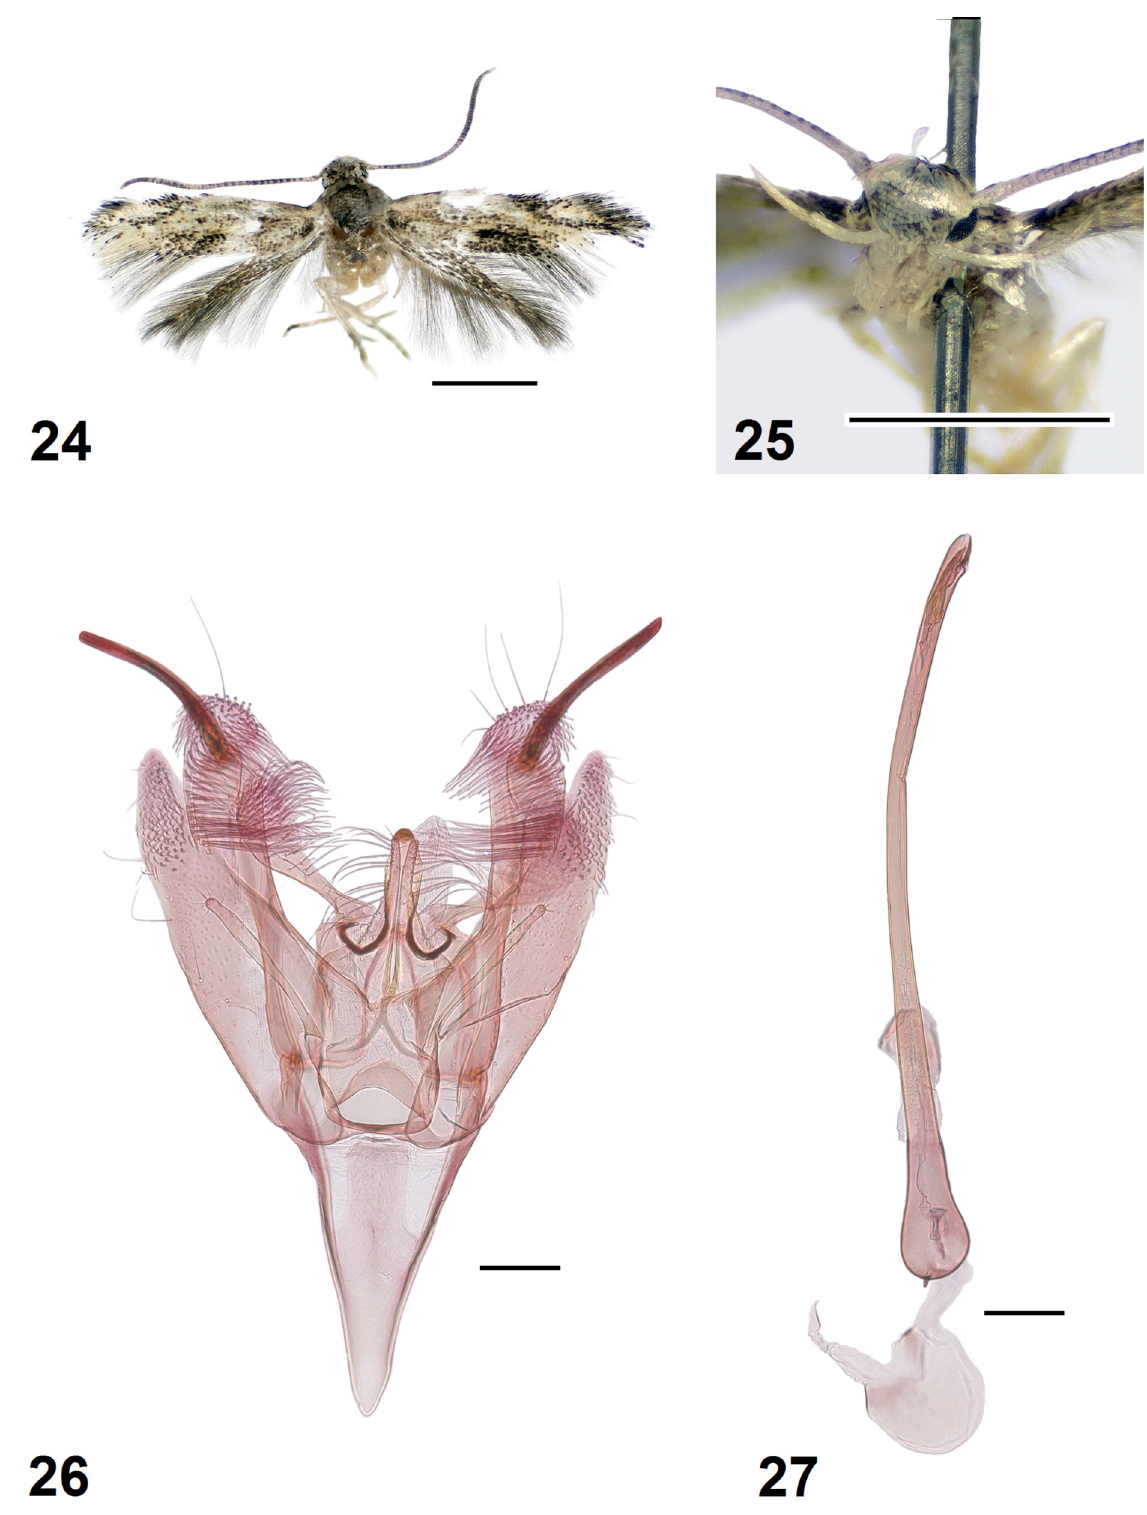
Figs 24–27. Elachista pellineni Sruoga & Kaila sp. nov., holotype, ♂ (MZH VS2/23.11.18). 24 . Adult. 25 . Head, latero-frontal view. 26 . General view of male genitalia (phallus removed). 27 . Phallus. Scale bars: 24–25 = 1 mm; 26–27 = 0.1